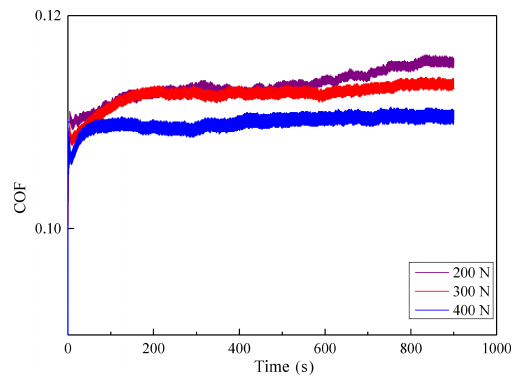
Figure 4. The COF of the cylinder liner under dry lubrication con-